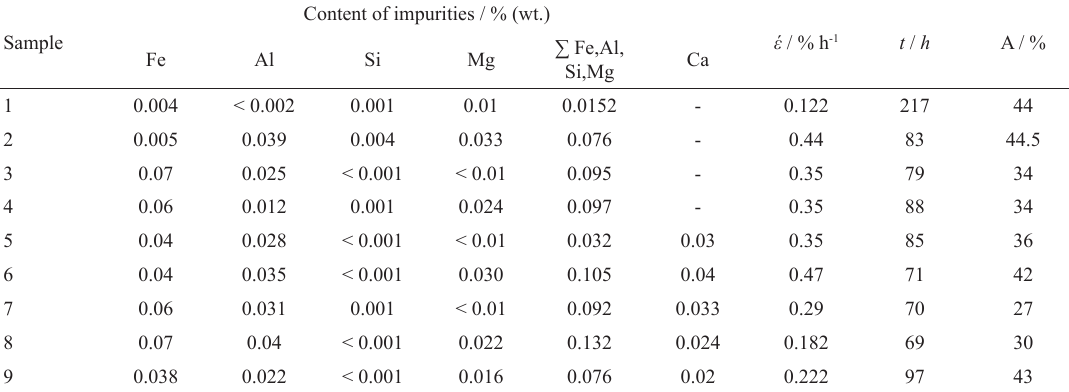
* all elements with symbol < are below the detection limit of AAS (method used to determine the content) Table 3: The values of the creep rate, rupture time and relative elongation depending on the content of impurities at a temperature of 1400 °C, at a stress of 5 MPa, for the alloy PtRh10 Content of impurities / % (wt.) Sample